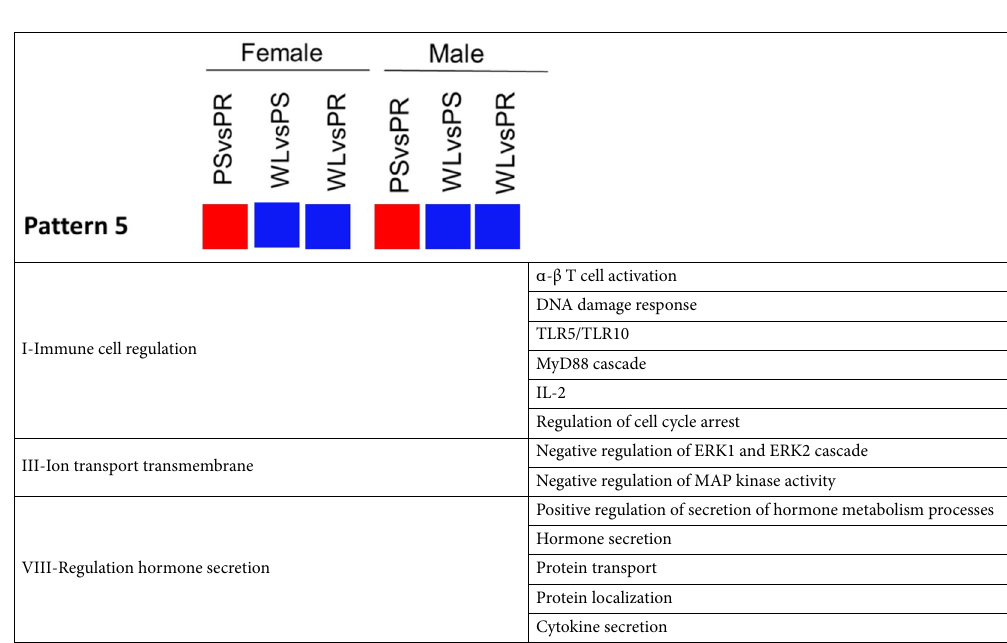
Table 5. Summary of clusters and gene sets included in the pattern 5 for the renal IRI time